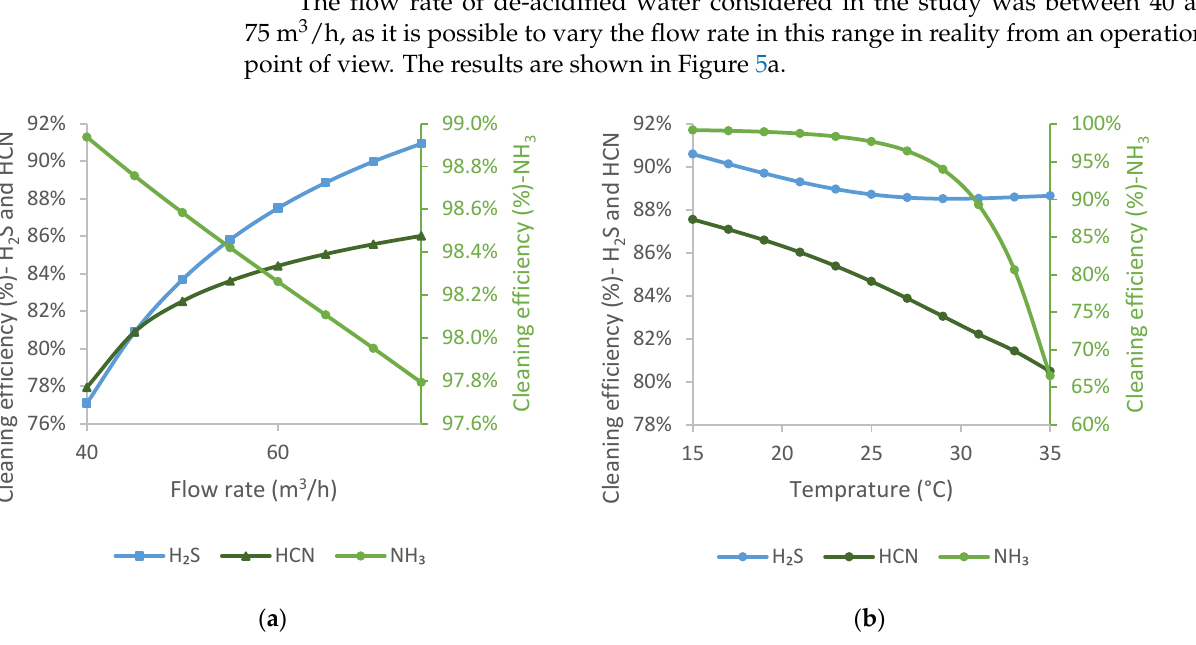
Figure 5. Effect of flow rate ( a ) and temperature ( b ) of de-acidified water.